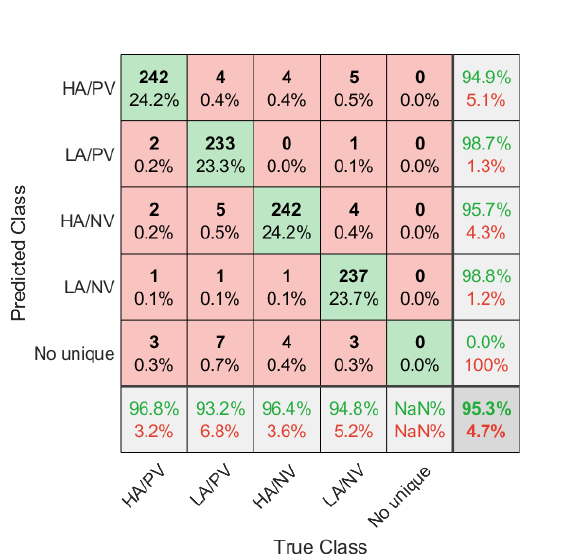
Figure 6. Confusion matrix using two dimensions—valence and arousal. No Unique—classifier could not decide due to a draw of votes for the scattered windows of one segment. The results were obtained using short and long experiment data, with 210 wavelet features, the Ensemble Bagged Tree classifier, and majority vote of the scattered windows of each